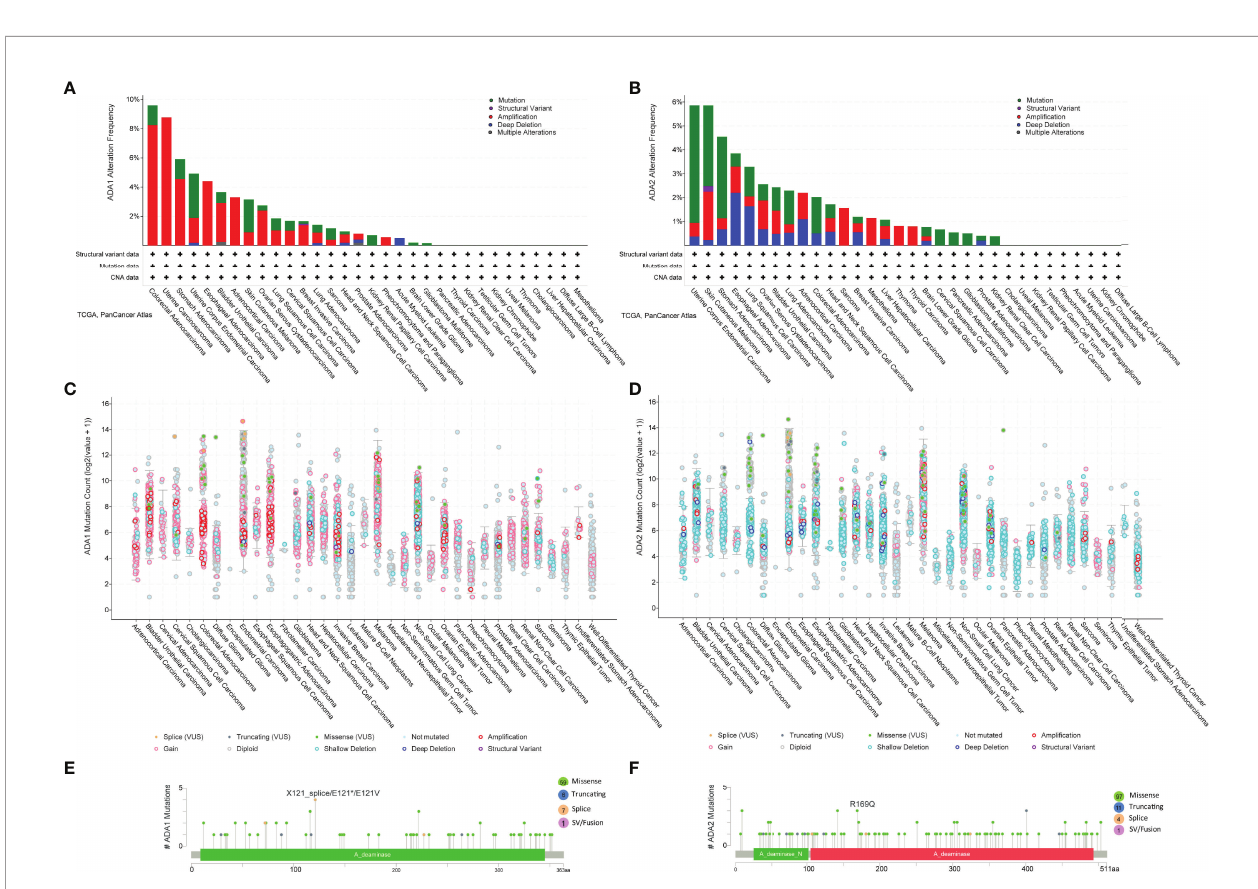
FIGURE 6 | ADA1 and ADA2 mutation landscape. (A, B) ADA1 and ADA2 mutation frequency in multiple TCGA pan-cancer studies according to the cBioPortal database. (C, D) The general mutation count of ADA1 and ADA2 in various TCGA cancer types by the cBioPortal database. (E, F) Mutation diagram of ADA1 and ADA2 in different cancer types across protein domains. TCGA, The Cancer Genome